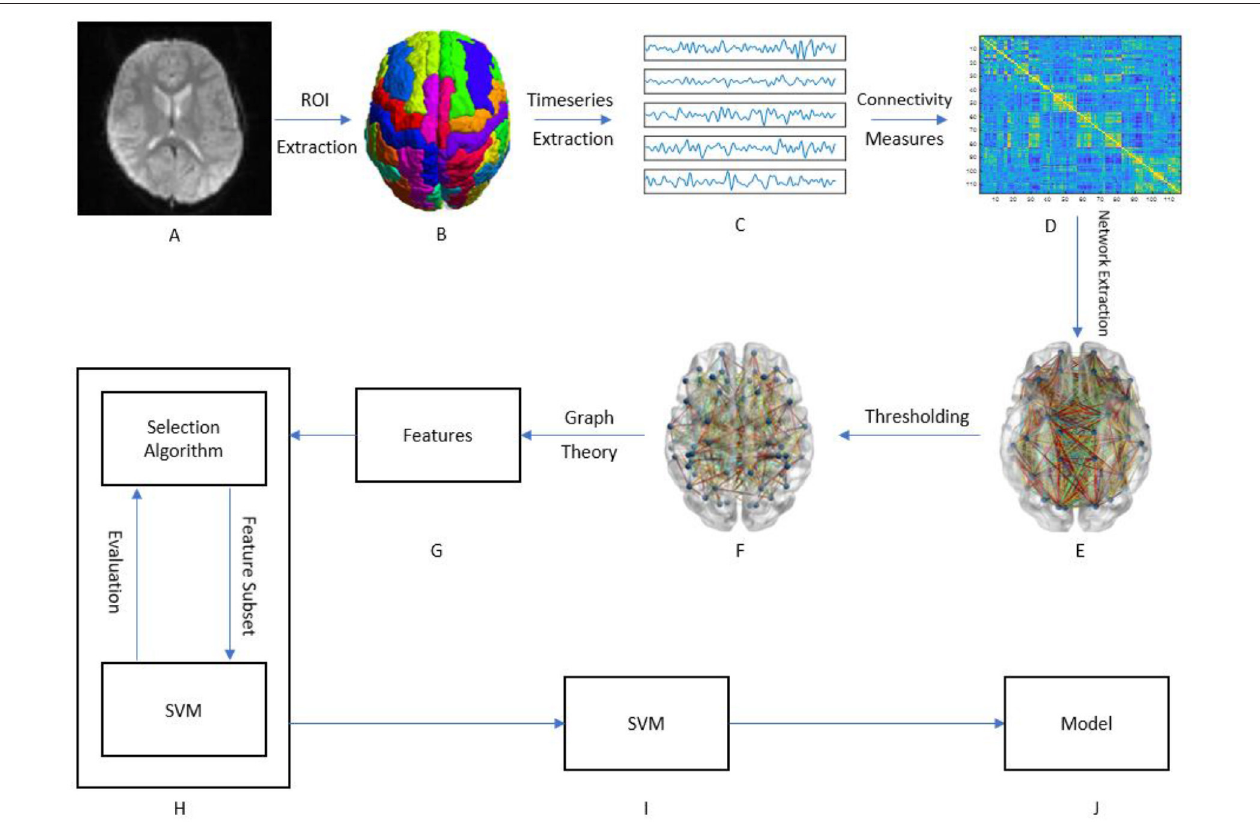
FIGURE 1 | Graphical framework of the experiment. (A) Raw fMRI images of subjects; (B) After preprocessing the brain is divided into 116 regions of interest (ROI); (C) By averaging the BOLD activity in each ROI, a time-series is extracted representing brain activity in that region; (D) Using different measures of connectivity, a connectivity matrix is generated from the ROI time-series quantifying the connectivity level between individual ROIs; (E) By treating the ROIs as graph nodes and the connectivity matrix as graph weights the brain network is expressed in graph form; (F) A threshold is applied to keep only the strongest connections; (G) Graph theoretical analysis is applied to the resulting graph from part F to obtain a feature vector for each subject; (H) A wrapper method called sequential feature selection is applied to choose a handful of features that contribute to the highest classification accuracy; (I,J) The resulting feature subset is passed to a linear SVM which trains a model to distinguish between ASD and